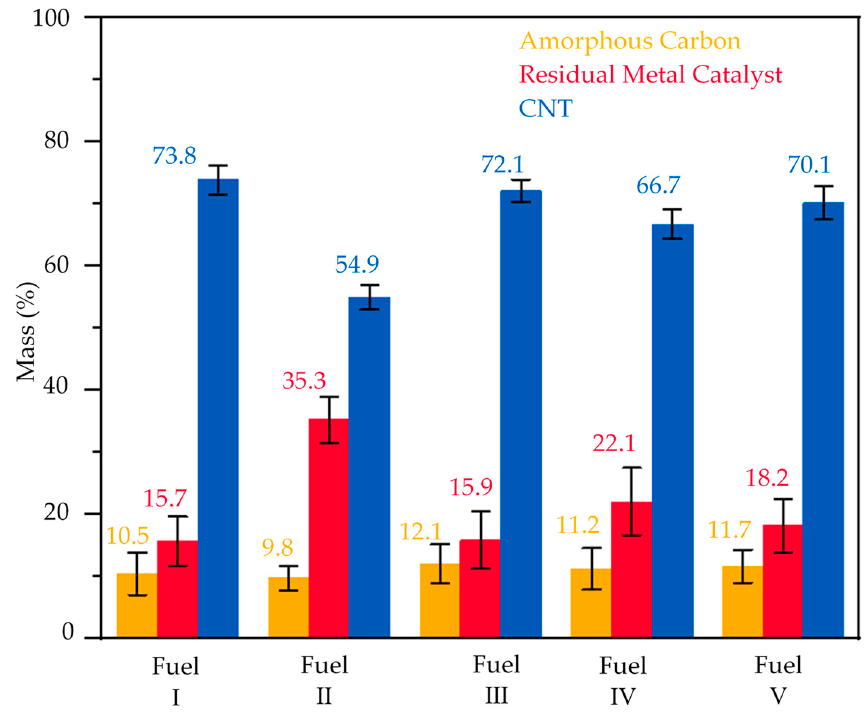
Figure 7. Mass percent content of amorphous carbon, residual metal catalyst, and CNT in the sam- ples from fuels I–V. from fuels